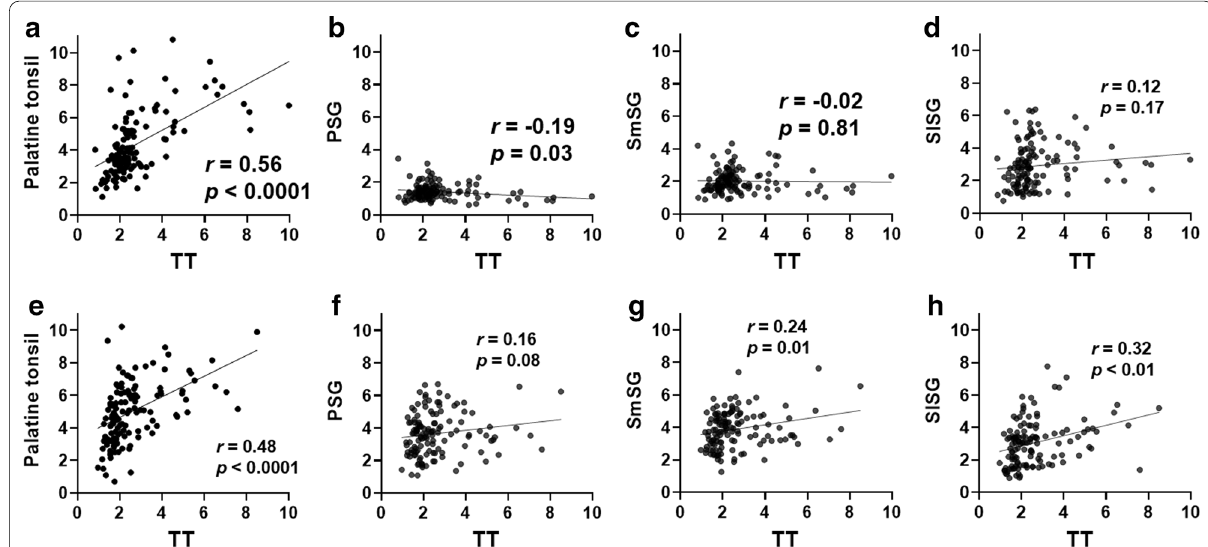
Fig. 4 Correlations of SUVmax in the tori tubarius (TT) with that in the palatine tonsil and the other major salivary glands ( a – d , [ 18 F]FDG; e – h , [ 11 C] methionine). PSG parotid salivary gland, SmSG submandibular salivary gland, SlSG sublingual salivary